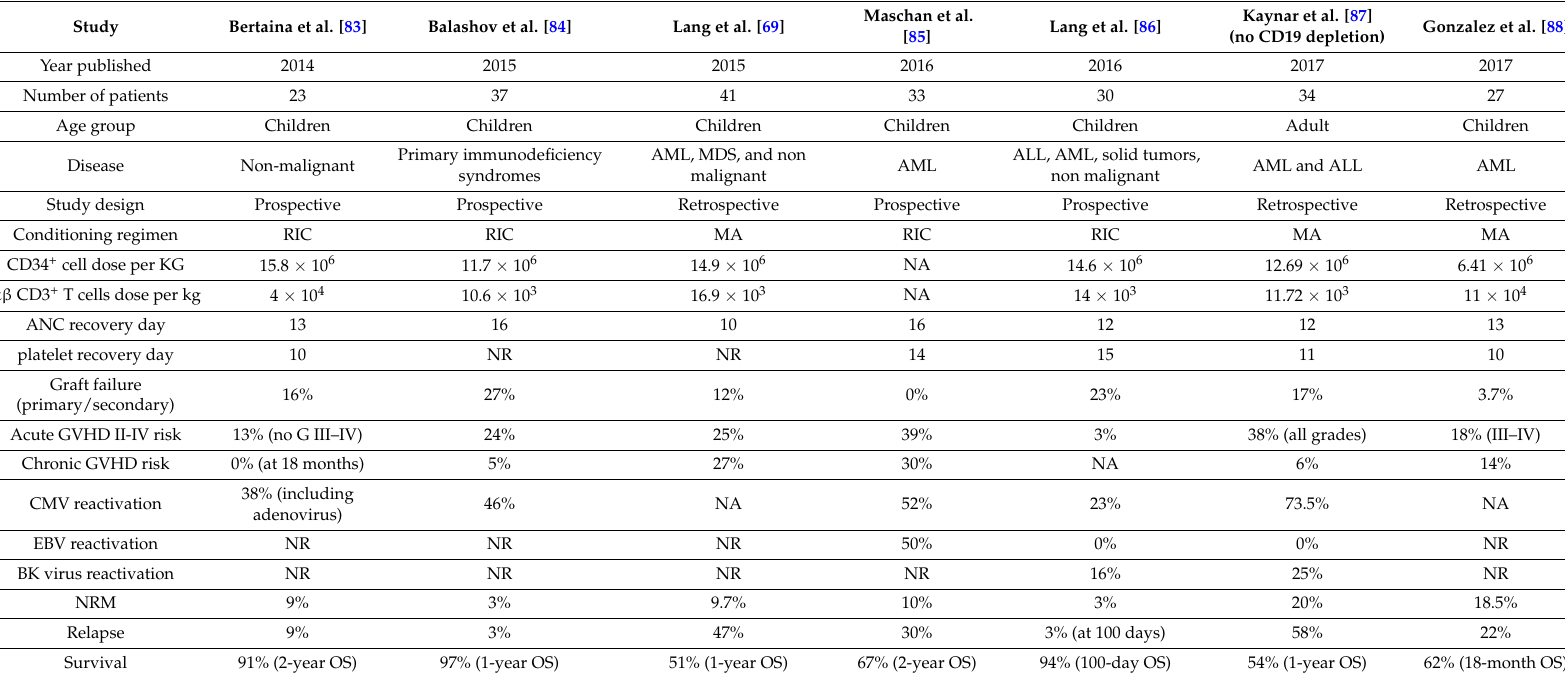
Table 1. Outcome of selected clinical studies using αβ T cell/CD19+ B cell depletion HCT. Only one study (Kaynar et al.) performed αβ T cell depletion without CD19+ B cell